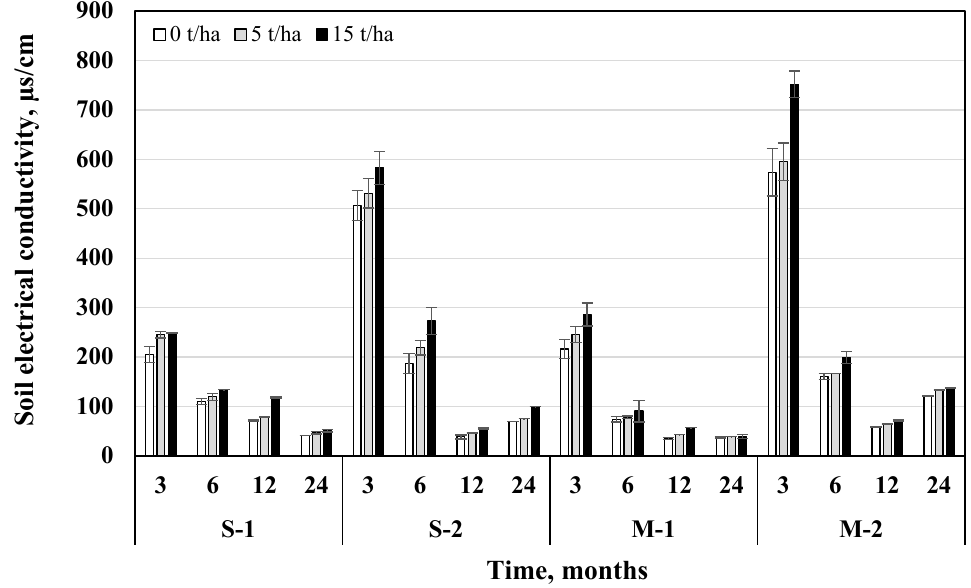
Figure 7. Influence of biochar on the changes of soil electrical conductivity in different tillage- fertilization systems (S—ploughless shallow tillage, M—direct drilling, 1—unfertilized, 2—fertilized) after 3, 6, 12, and 24 months from the beginning of the experiment, n = 2.